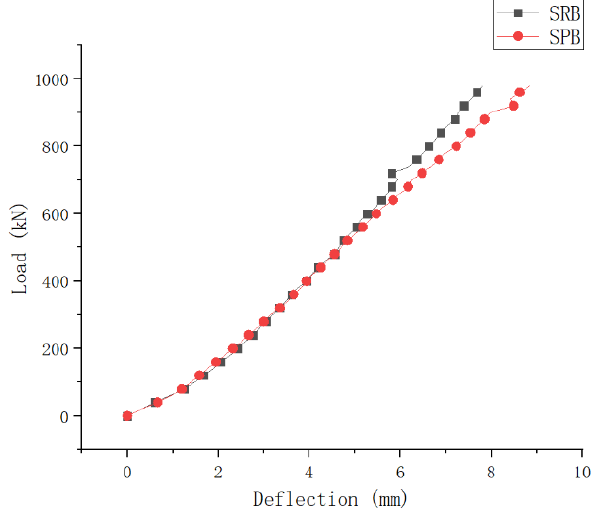
Figure 9. Load-Deformation Curve of Experimental Beam.